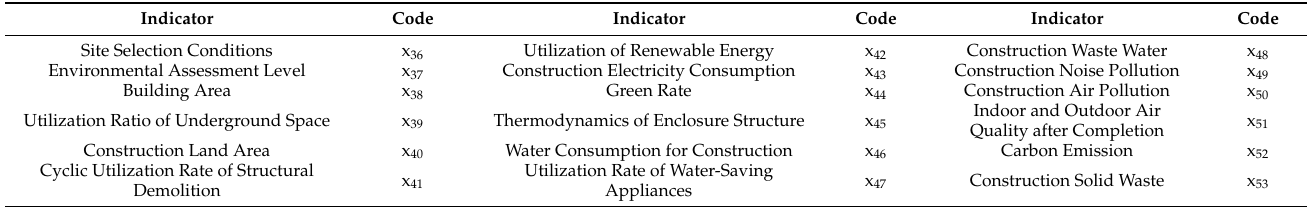
Table 4. The greenness indicators.